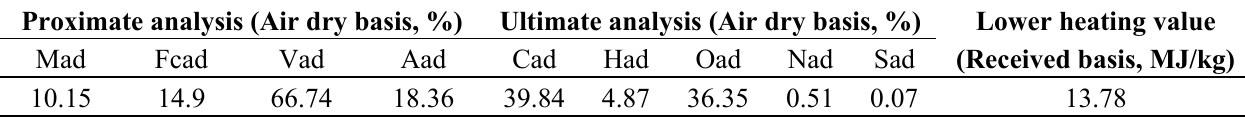
Table 3. Proximate and ultimate analysis of the rice husk.